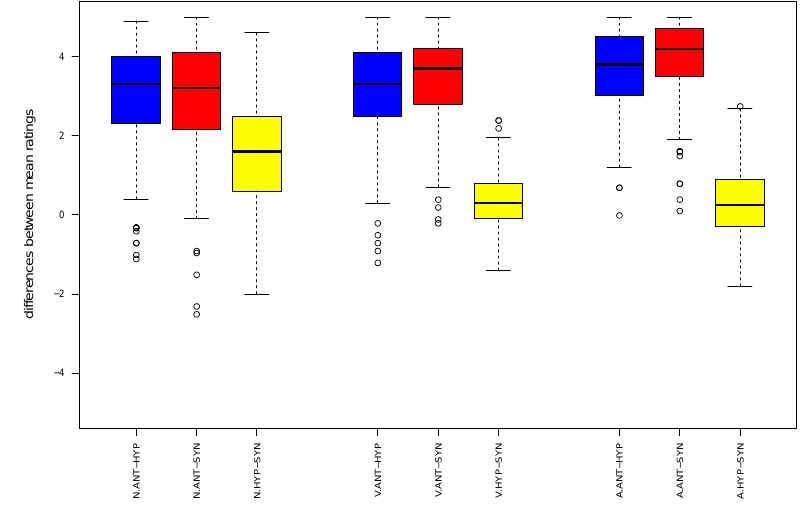
Figure 1: Human distinction of paradigmatic